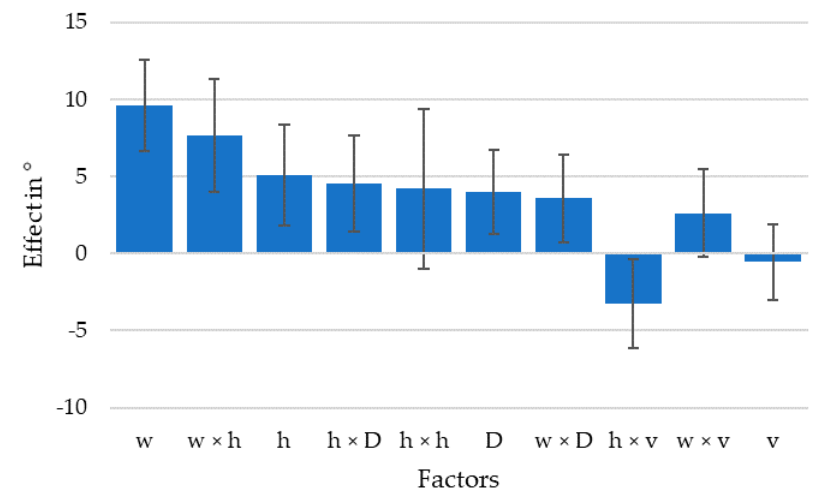
Figure 9. Effects of extrusion parameters on fiber alignment sorted by magnitude for 95% confidence interval, Y axis is the effect on fiber orientation if the parameter is varied between its upper and lower limit.